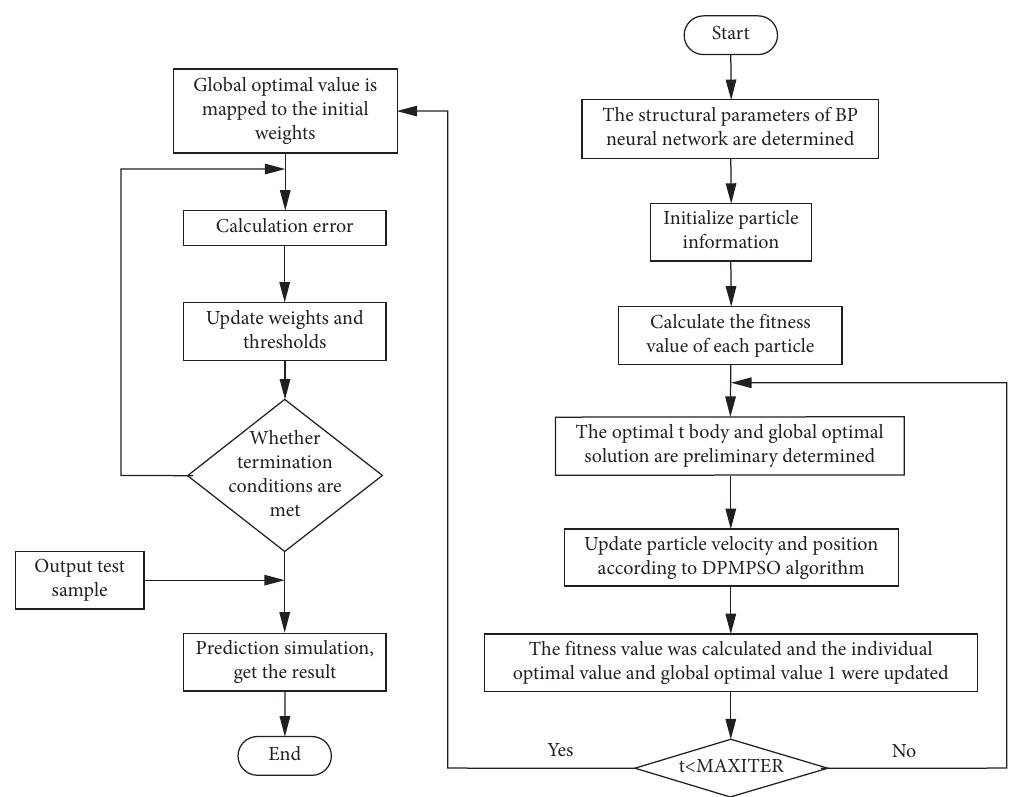
Figure 2: DPMPSO-BP